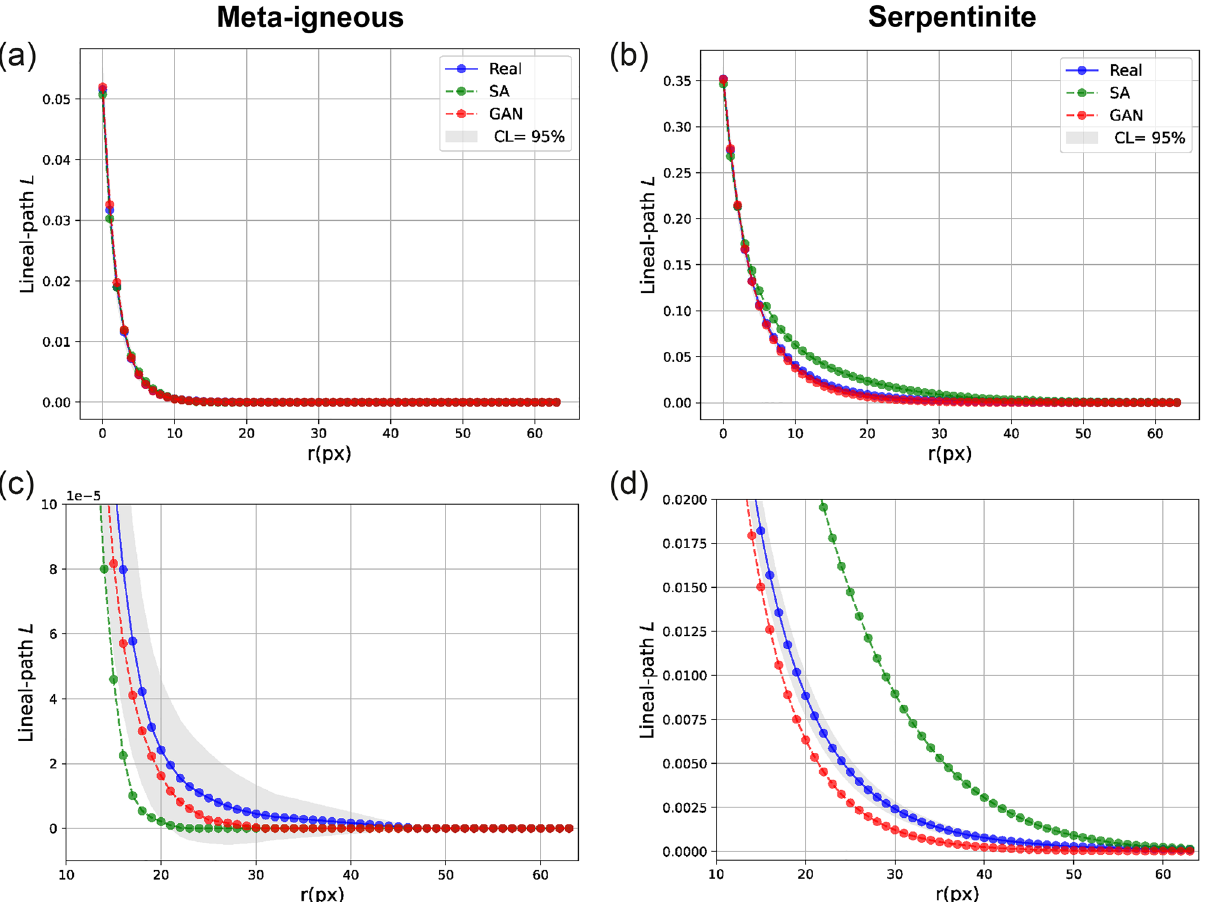
Figure 7. The average lineal-path functions L calculated from real (blue), SA-reconstructed (green), and GAN- reconstructed (red) images. Grey areas in ( c , d ) are 95 percent confidence bounds around real curves. A better match between curves is derived via GAN reconstructions in both samples. CL = confidence